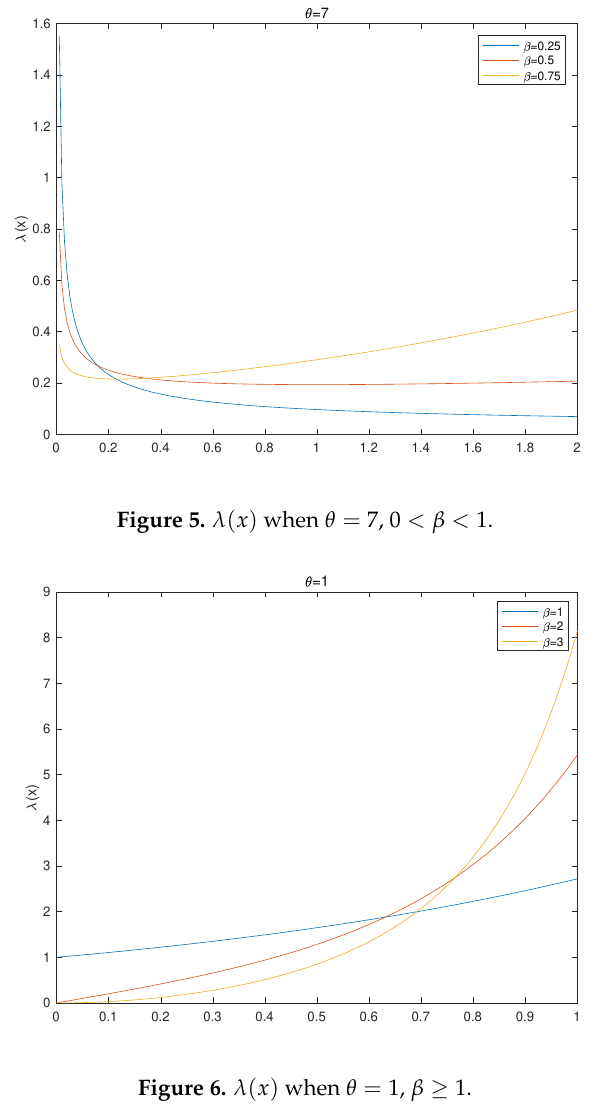
Figure 6. λ ( x ) when θ = 1, β ≥